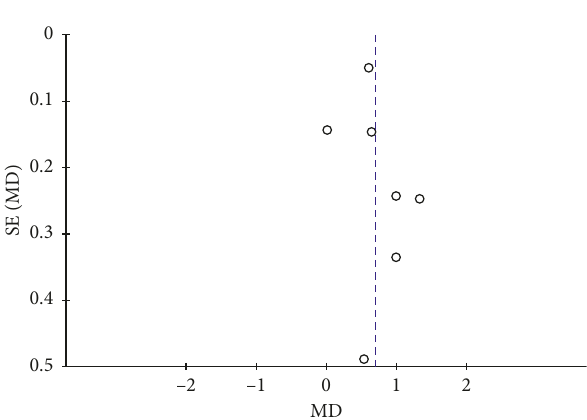
Figure 7: Funnel plot showing the publication bias of studies comparing pain scores shortly after the